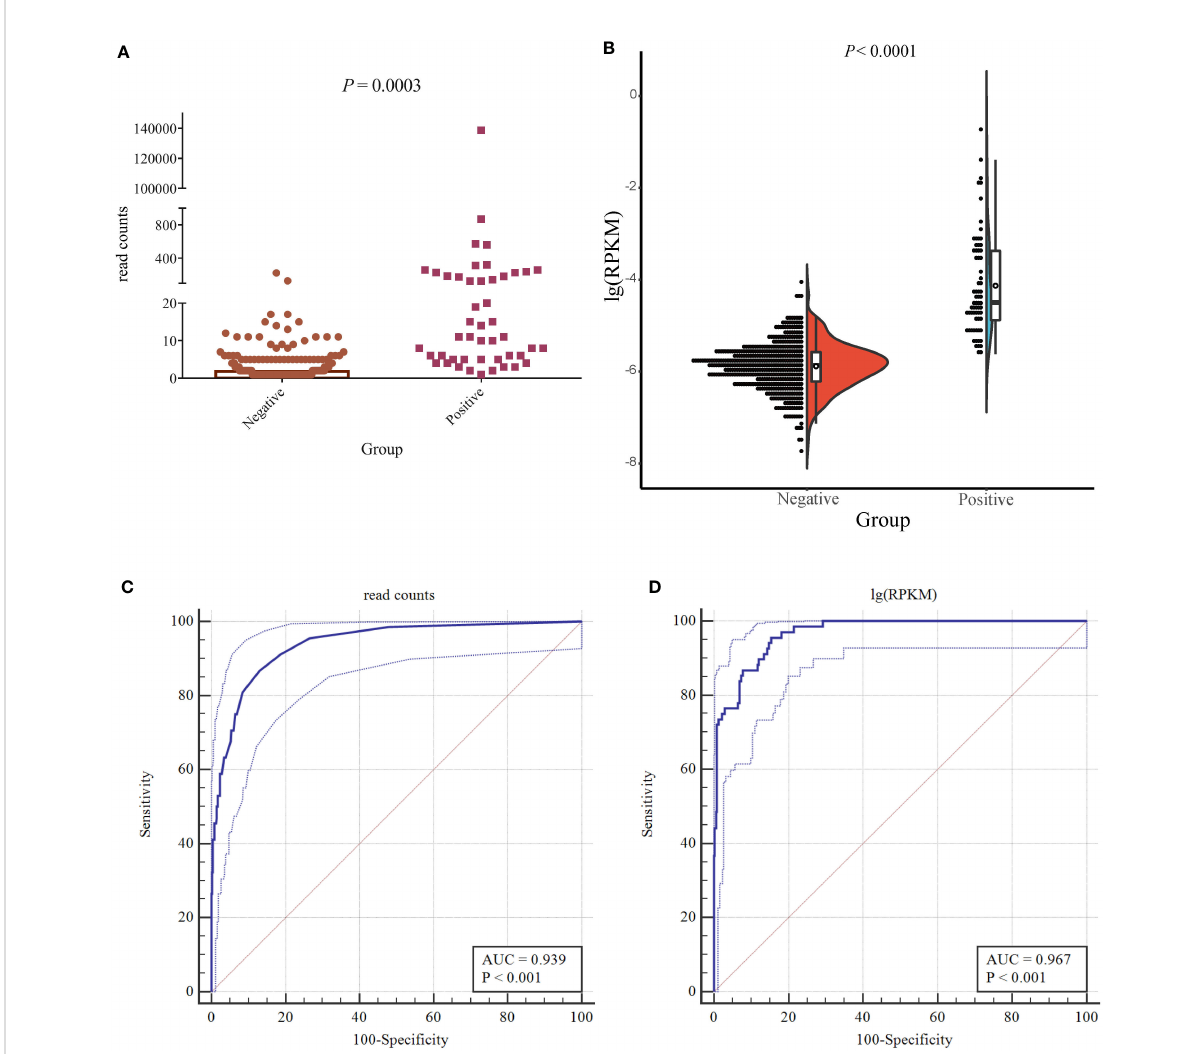
FIGURE 3 Accuracy of mNGS. (A) The difference in the number of detected reads between true- and false-positive fungi. (B) The half violin diagram shows the difference in lg(RPKM) values between true- and false-positive fungi. (C, D) Evaluating the performance of lg(RPKM) (C) and read counts (D) between the true- and false-positive pathogenic fungal groups using ROC